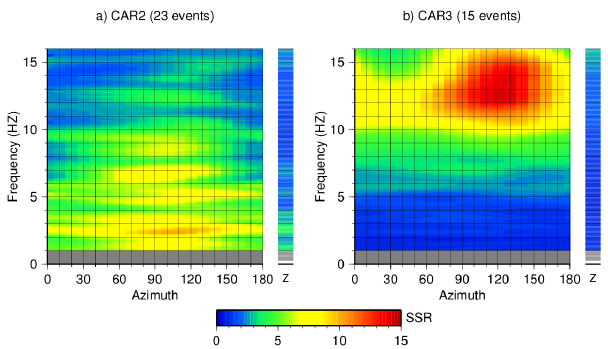
Fig. 2. Azimuthal variation of SSR values obtained for the sites of the accelerometer stations CAR2 (a) and CAR3 (b) , averaging spectral ratios calculated for 23 and 15 seismic events, respectively, in comparison to the reference site CAR4. Vertical bars show the SSR values relative to vertical component.